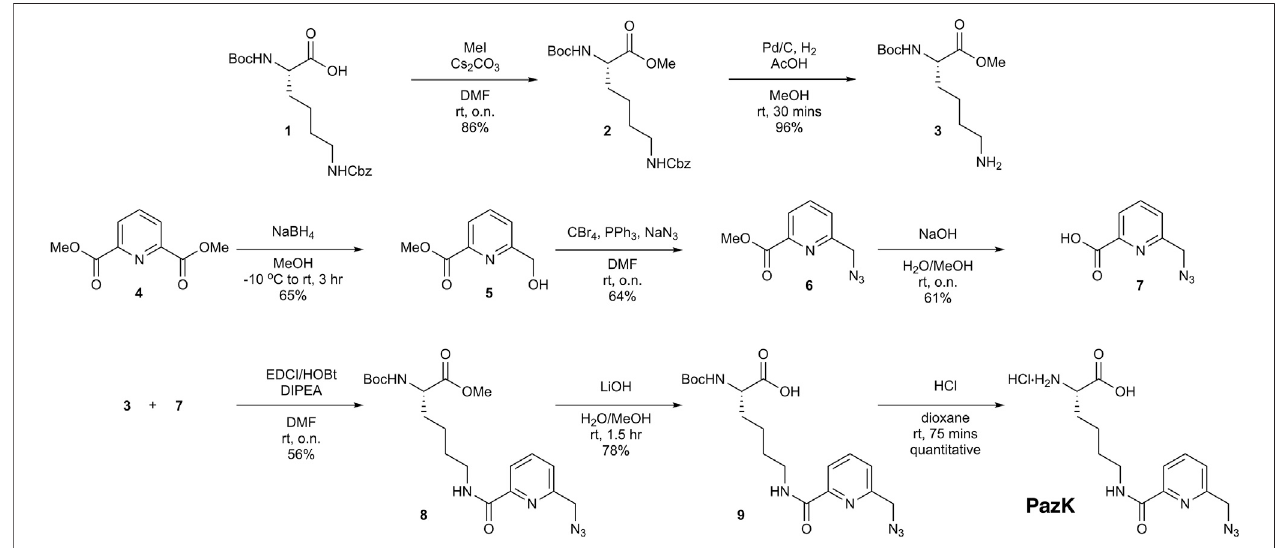
FIGURE 1 | Chemical synthesis of picolyl azide-lysine (PazK).